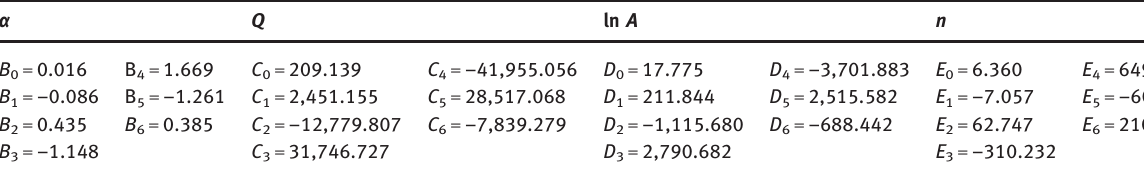
Table 3: Comparison of Q and n of AISI 410 stainless steel.